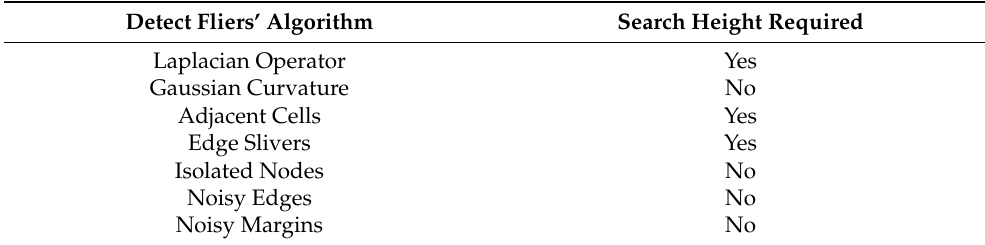
Table 1. Algorithms currently in use by the Detect Fliers